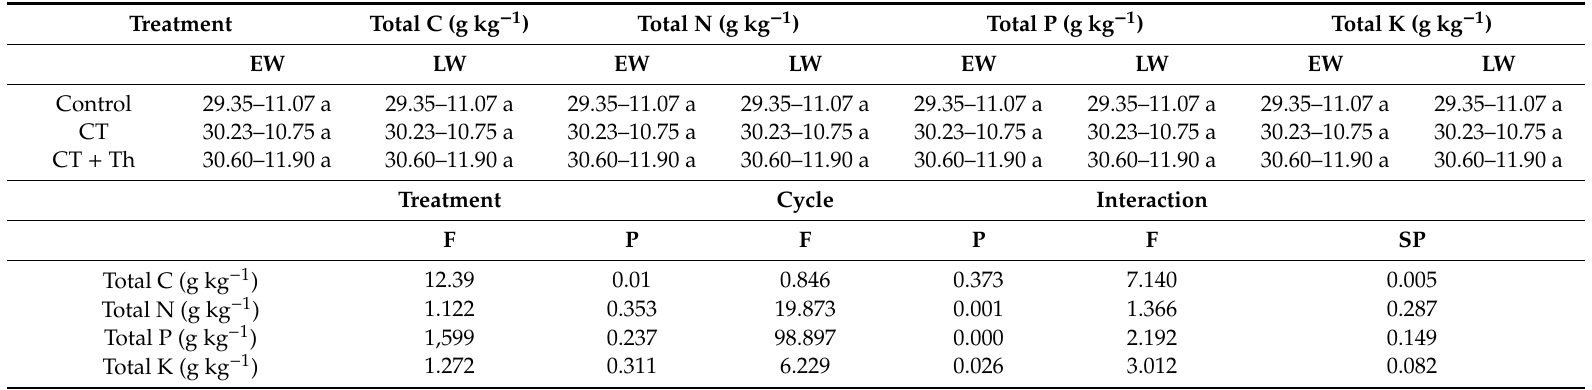
Table 4. Influence of di ff erent compost tea (CT) treatments on soil chemical properties and soil microbial activity in both experiments after harvesting. Values are the mean + SD; n = 3). Control: sprayed distilled water (12 m 3 per ha); CT: sprayed compost tea (12 m 3 per ha); CT + Th: sprayed compost tea (12 m 3 per ha) and